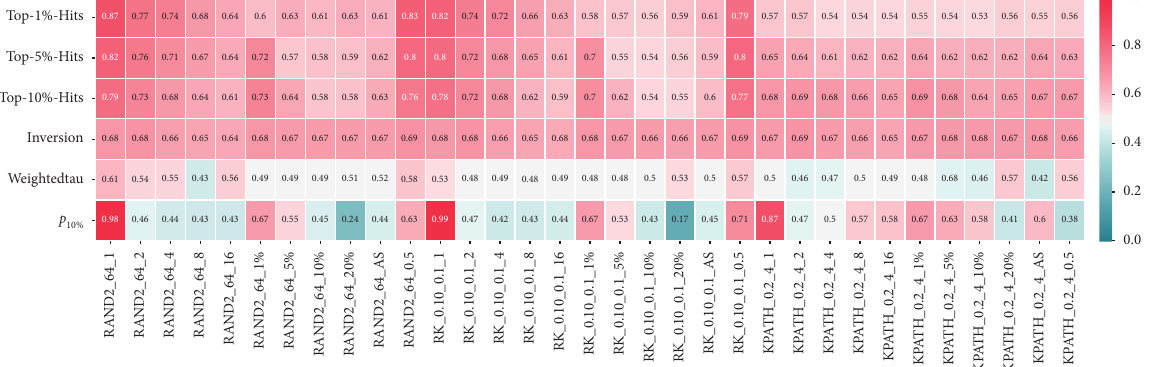
Figure 9: Average measure values of different competitors.